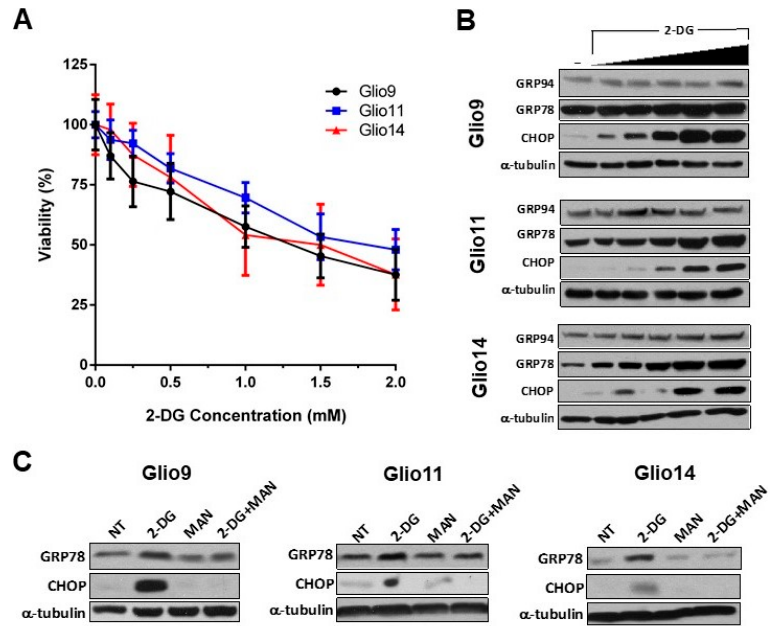
Figure 4. 2-Deoxy-D-glucose (2-DG) induces ER stress in GSCs in a dose-dependent manner. ( A ) CellTiter 96 ® AQ ueous One Solution Cell Proliferation (Promega, Madison, WI, USA) assay of Glio9, Glio11, and Glio14 treated with increasing doses of 2-DG for 72 h. Viability is reported as mean ± SEM. Data represent average values of at least three independent experiments. ( B ) Western blot analysis for ER stress markers (GRP78, GRP94, and CHOP) in GSC lines treated with 0.0, 0.25, 0.5, 1.0, 2.0, and 4.0 mM of 2-DG for 24 h. ( C ) Western blot analysis of GSCs treated with 2-DG and/or mannose to determine mechanism of rescue from ER